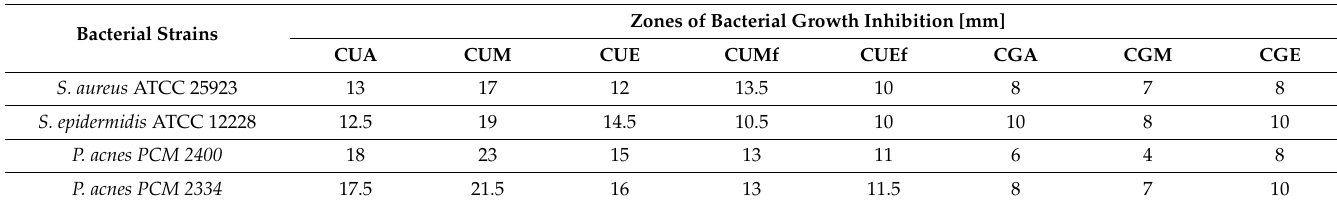
Table 4. Zones of bacterial growth inhibition as an antibacterial Cephalaria uralensis and C. gigantea extracts activity. Zones of Bacterial Growth Inhibition [mm] Bacterial Strains CUA CUM CUE